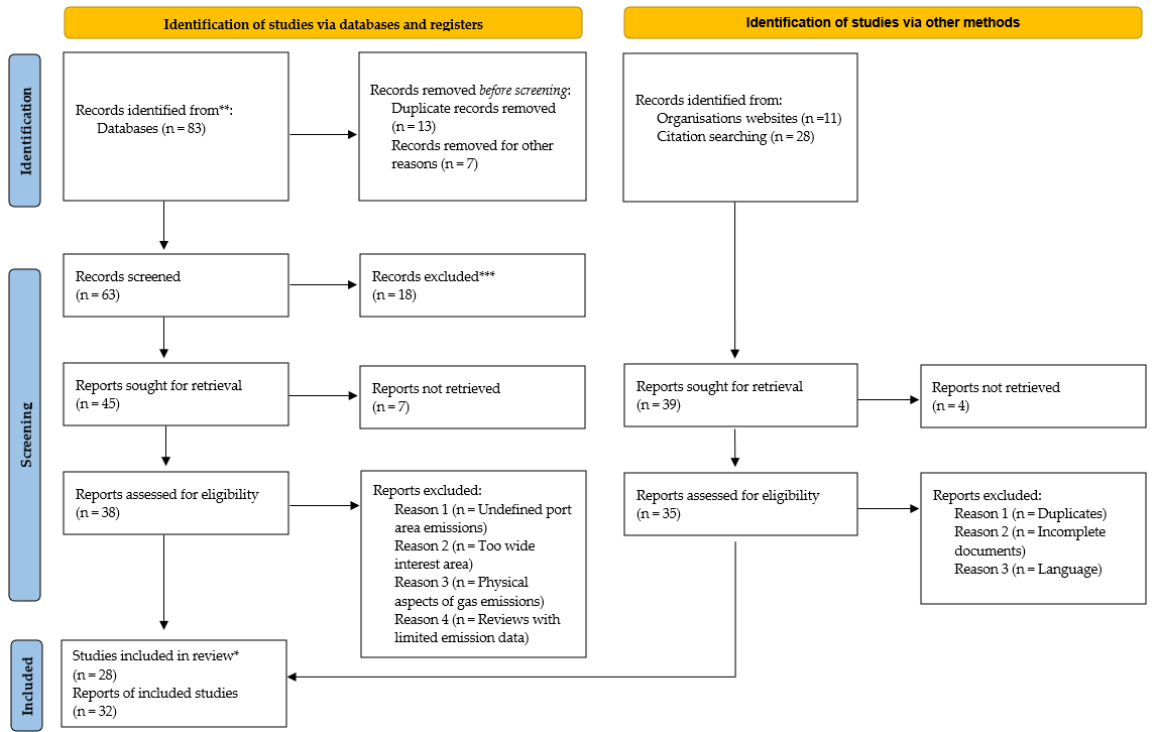
Figure 2. PRISMA 2020 analysis flow diagram for new systematic reviews which included searches of databases, registers and other sources [19] * According to the PRISMA glossary of terms, a study